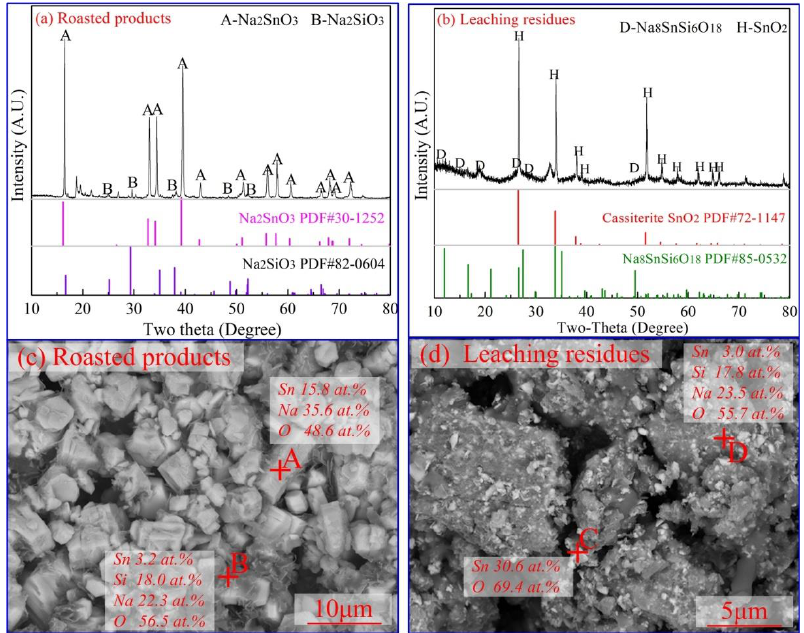
Figure 3. Phase analysis of the roasting products and the leaching residues. (( a )-XRD results of roasted products, ( b )-XRD results of leaching residues, ( c )-SEM analysis of the roasted products, ( d )-SEM analysis of leaching residues).